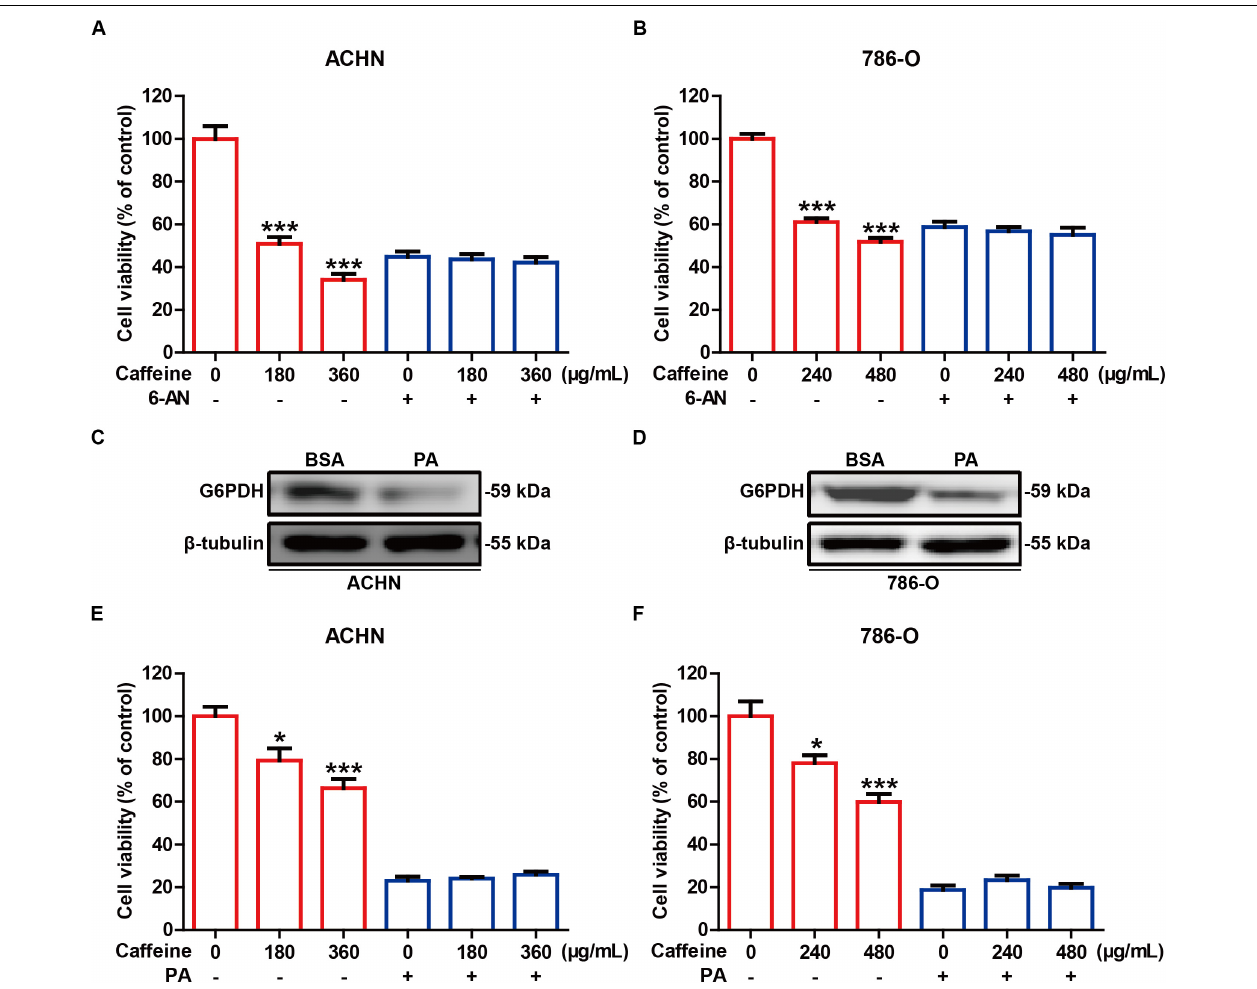
FIGURE 4 | G6PDH inhibition abrogates the inhibitory effects of caffeine on RCC cell growth. (A,B) ACHN and 786-O cells were pretreated with or without 6-AN for 4 h and subsequently stimulated with caffeine for 48 h, and then subjected to MTT assay. *** P < 0.001 versus the control group. (C,D) The expression level of G6PDH in ACHN and 786-O cells treated with PA, as determined by western blotting. Representative images are displayed. (E,F) ACHN and 786-O cells were pretreated with or without PA for 4 h and subsequently stimulated with caffeine for 12 h, and then subjected to MTT assay. * P < 0.05 and *** P < 0.001 versus the control group. Data are shown as means ± SEM of triplicated